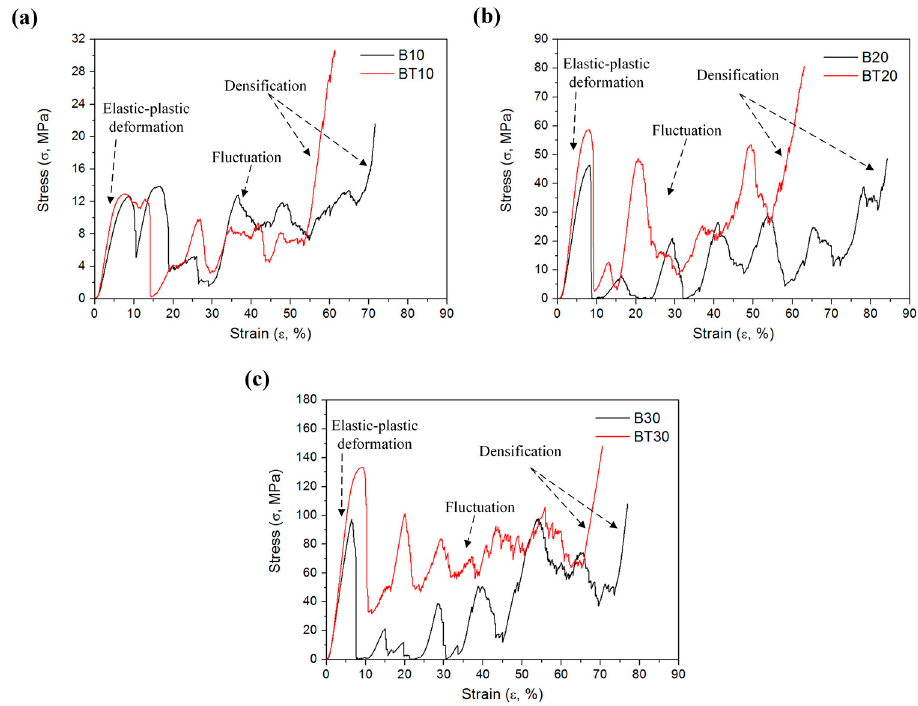
Figure 6. Stress–strain curves of CAD-based and TPMS-based samples in different volume fractions during compression tests. Volume fraction = ( a ) 10%, ( b ) 20%, ( c ) 30%. Table 1. Deformation of CAD ‐ based and TPMS ‐ based samples at different strains during compression tests.